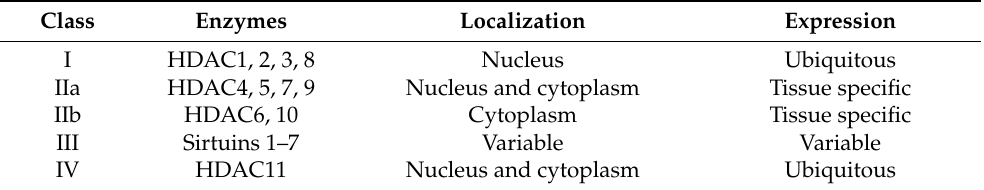
Table 1. Classification of HDACs and their distribution in human according to [2]. Class Enzymes Localization Expression